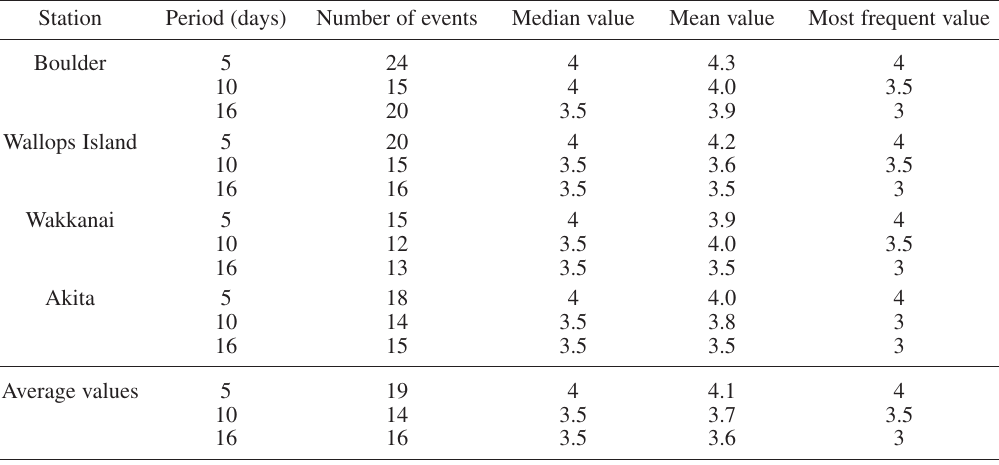
Table II. Statistics of persistence of planetary wave type oscillations in foF 2 for stations from the Northern America and Japan based on the Paul wavelet transform («absolute» evaluation). The average values for medi- ans and the most frequent values are presented with a step of 0.5. Station Period (days) Median value Boulder